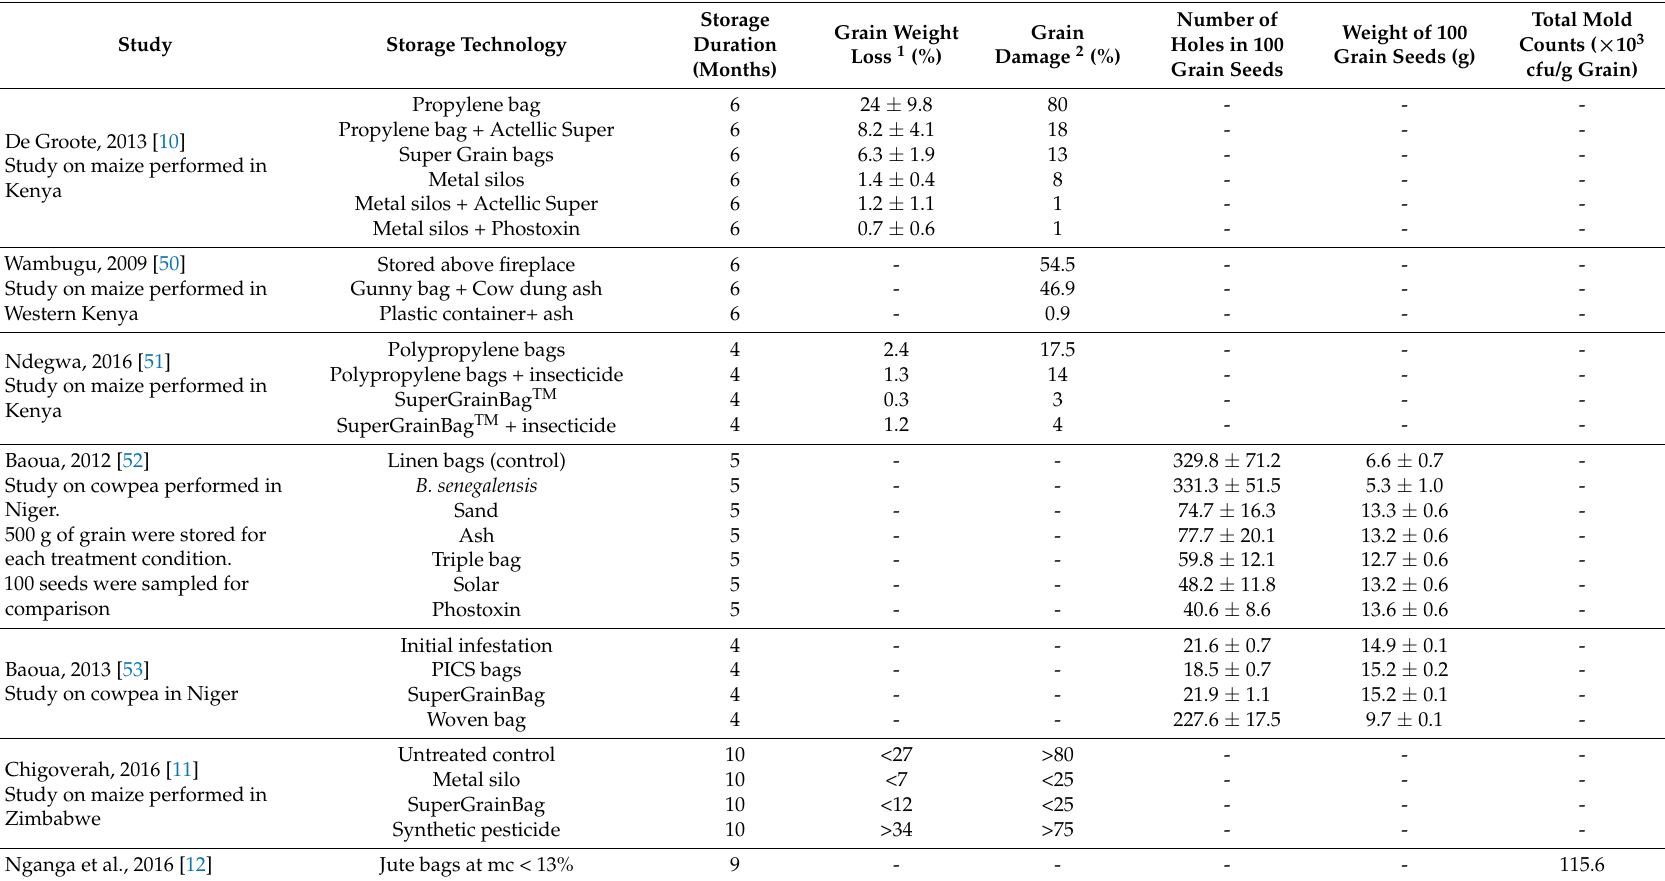
Table 3. Effectiveness of different grain storage practices of smallholder farmers in developing